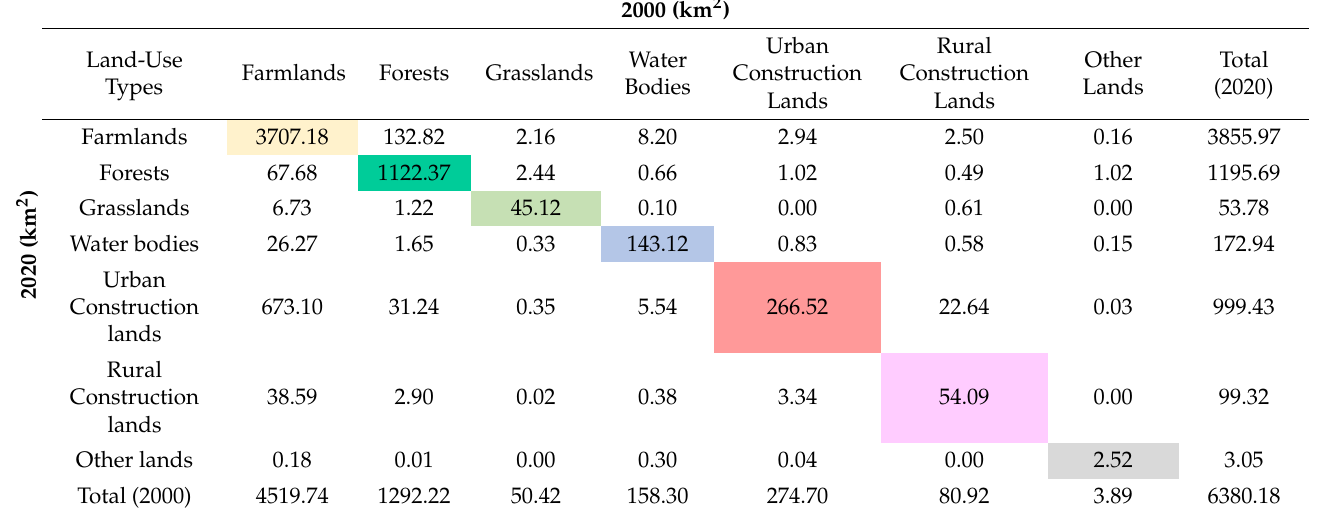
Table 4. Transfer matrix of land-use from 2000 to 2020.